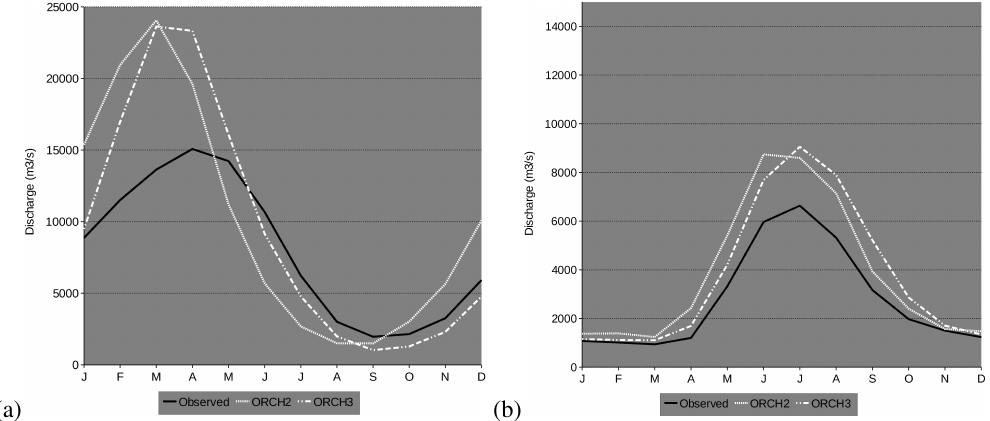
Fig. 15. Mean monthly seasonal discharge (m 3 s − 1 ) at (a) Guajara-Mirim and (b) Caracarai for simulation ORCH3 compared to ORCH2 and observations, over the mean time period 1980–2000.